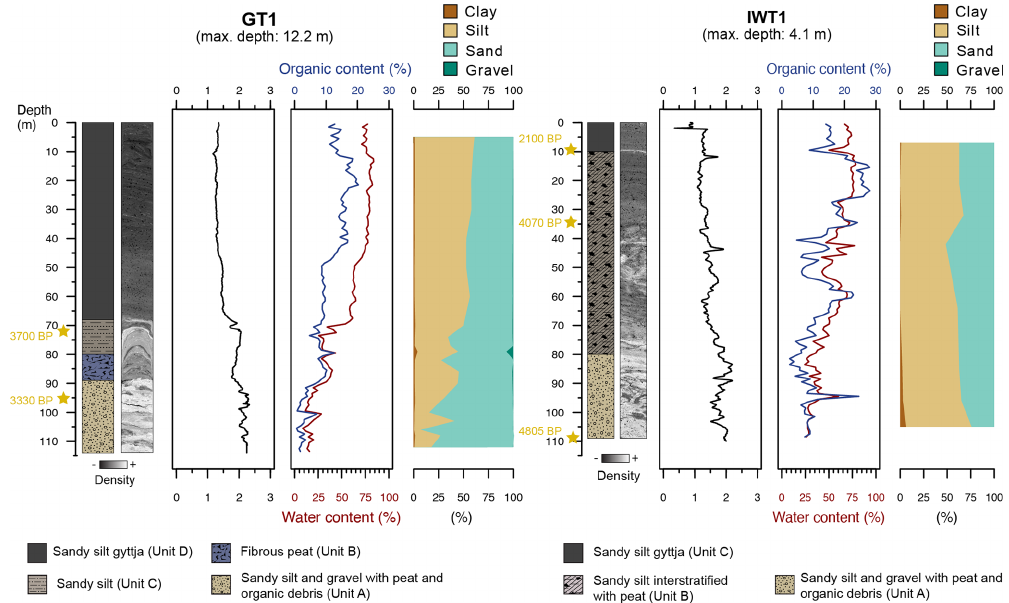
Figure 5. General stratigraphy of cores sampled in lakes GT1 (deep glacial thermokarst lake, max depth = 12.2m) and IWT1 (shallow ice-wedge thermokarst lake, max depth: